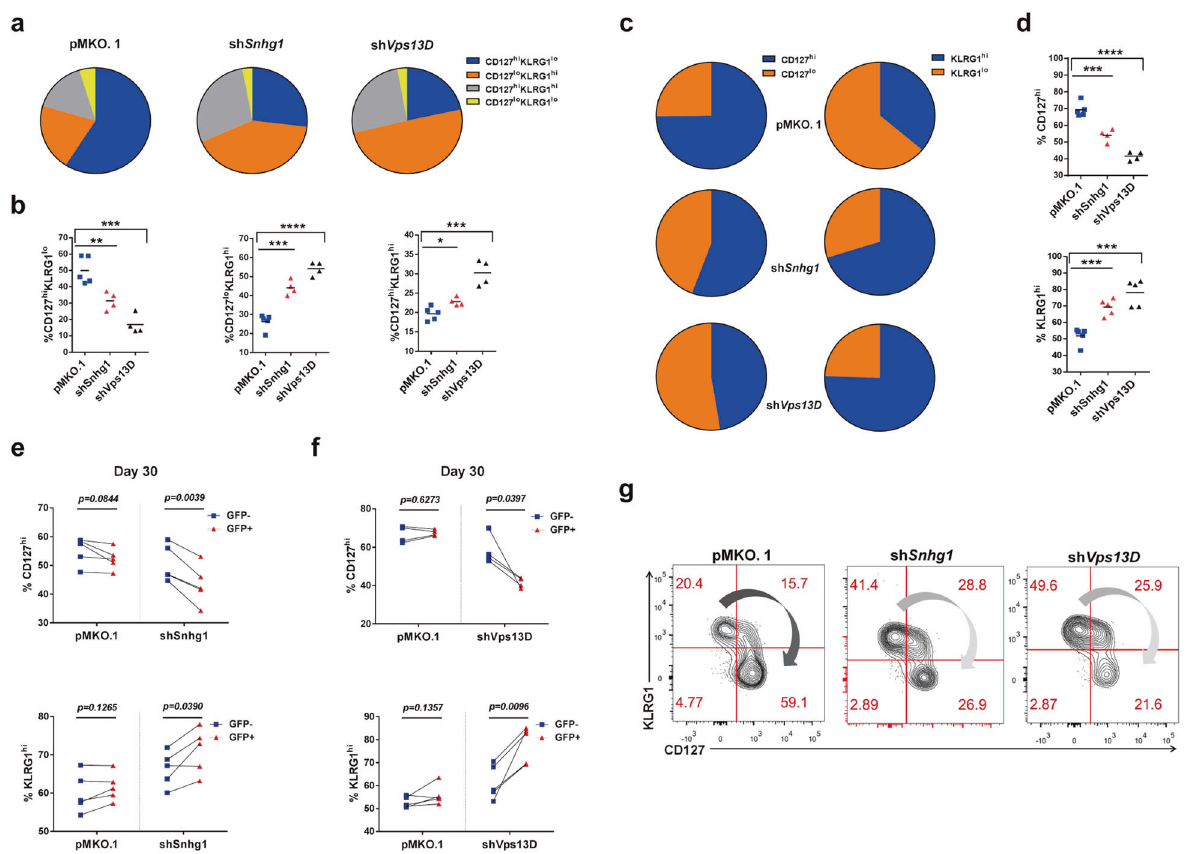
Fig. 3 Snhg1 and Vps13D depletion impair memory while accumulate effector CD8 T cells. a – d Representative pie charts ( a , c ) with quanti fi cation ( b , d ) of the indicated cell proportion in pMKO.1/shSnhg1/shVps13D GFP + P14 cells on day 45 p.i. e , f The internal analysis of indicated cell proportion by comparing the GFP − with GFP + P14 CD8 T cells in the same mice in control or sh Vps13D /sh Snhg1 groups on day 30 p.i. g Representative fl ow cytometry to show the effect of sh Snhg1 and sh Vps13D reducing memory with retention of effector T cells on day 45 p.i. Data are representative of two or three independent experiments with at least four mice per group (error bars denote s.e.m.). * p < 0.05, ** p < 0.01, *** p < 0.001, **** p < 0.0001 (paired or unpaired two-tailed t -test). See also Fig. S3, Tables S1,